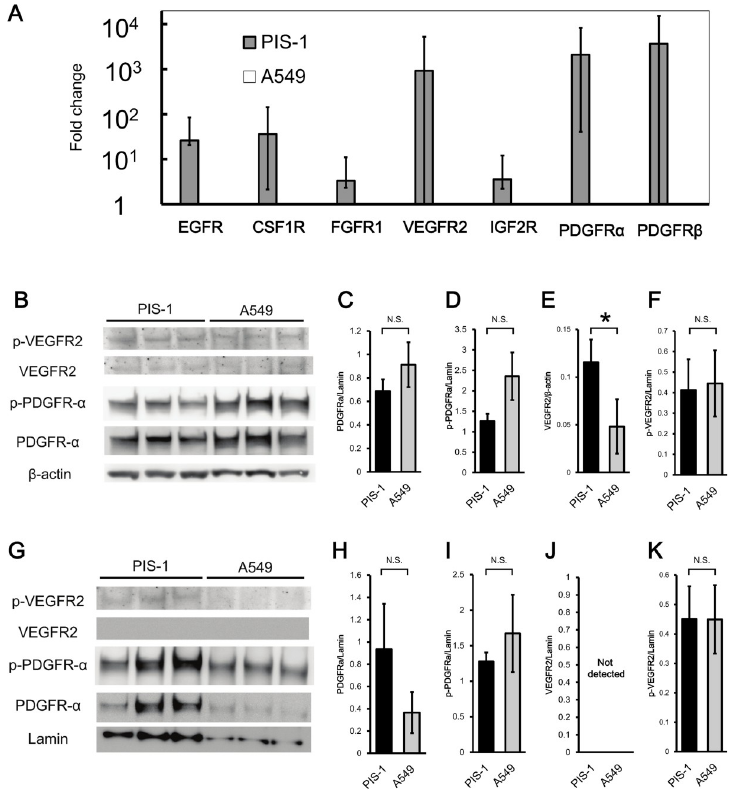
Fig 5. PCR array and western blot analysis for tyrosine kinase receptors. (A) PCR array analysis showing expression of tyrosine kinase receptors in PIS-1 cells in comparison to A549 cells. Vertical axis is in log scale. (B) Western blot analysis for whole protein of PIS-1 and A549 cells. The signal strength of platelet-derived growth factor receptor (PDGFR)- α (C), phospho-PDGFR- α (D), vascular endothelial growth factor receptor 2 (VEGFR2) (E), and phospho- VEGFR2 (F) were expressed as a ratio to β -actin. � :p < 0.05 vs A549 cells. (G) Western blot analysis for nuclear protein of PIS-1 and A549. The signal strength of PDGFR- α (H), phospho-PDGFR- α (I), VEGFR2 (J), and phospho-VEGFR2 (K) were expressed as a ratio to lamin. Error bars show standard deviation. � :p < 0.05 vs A549 cells, N.S.: not significant.